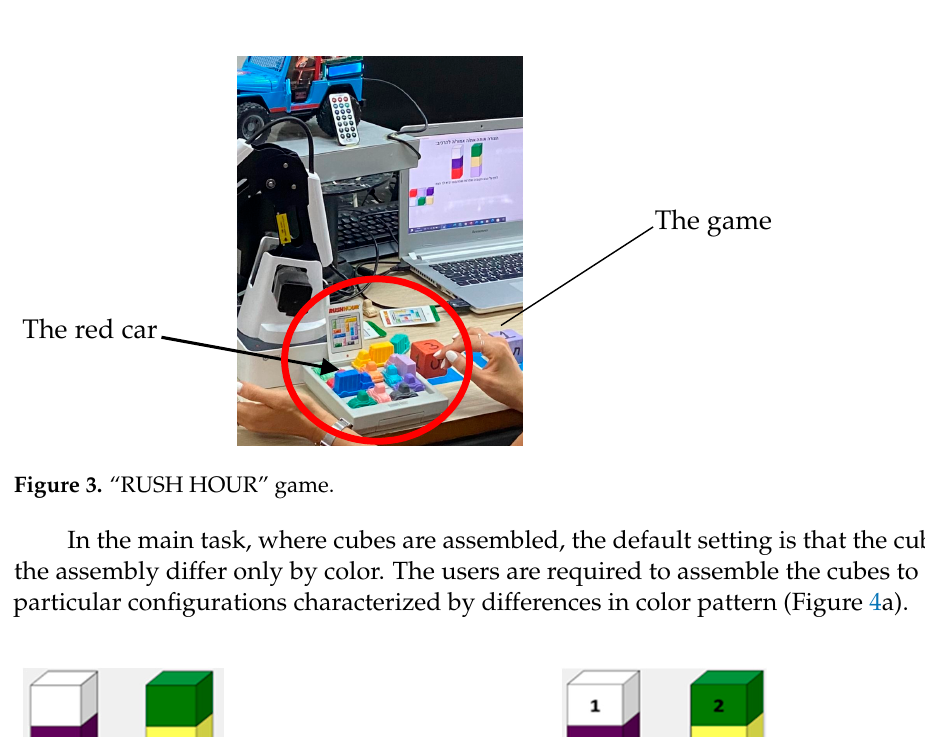
Figure 3. “RUSH HOUR” game.